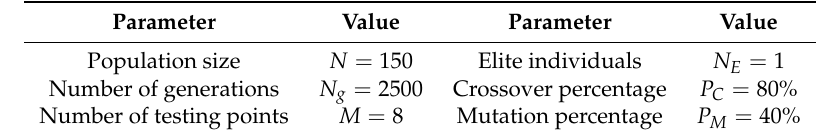
Table 5. Genetic algorithm parameters.